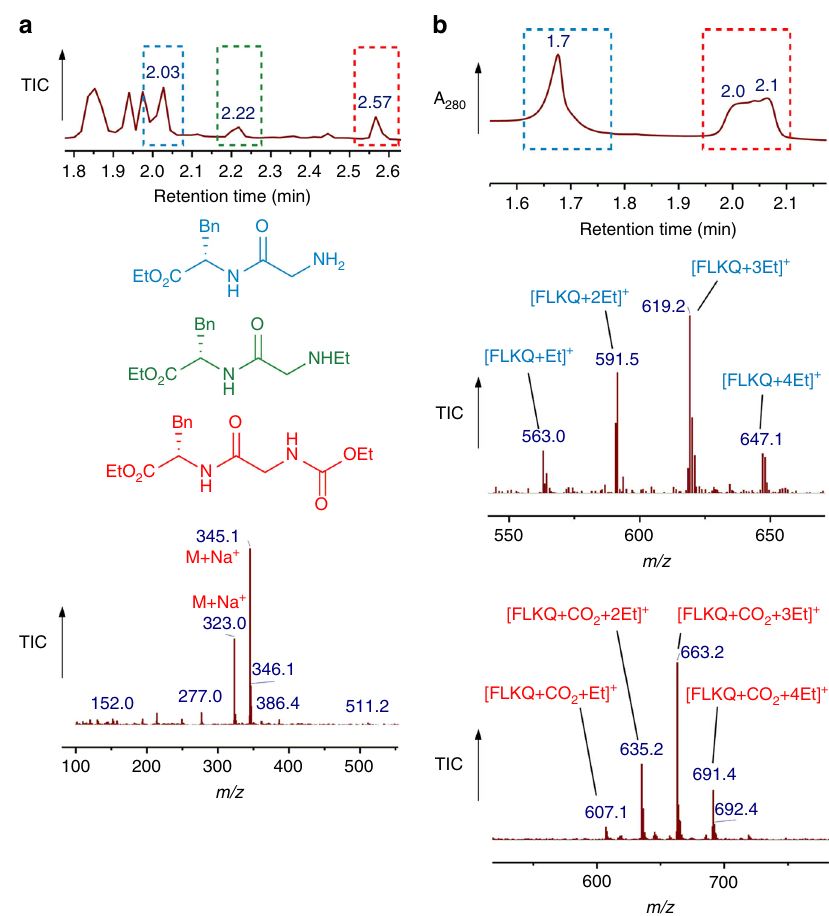
Fig. 4 Carbamate trapping on di- and tetrapeptides. a Total ion chromatogram of the carbamate-trapping reaction mixture of Gly-Phe with TEO, and m/z pro fi le for species at retention time 2.57 min. The major products of the trapping reaction are Gly-Phe ethylated on the Phe- α -carboxylate (retention time 2.03 min), Gly-Phe ethylated on the α -carboxylate of Phe and the α -NH 2 group of Gly (retention time 2.22 min) and Phe-Gly ethylated on the carbamate of the α -NH 2 -group of Gly and the α -carboxylate group of Phe (retention time 2.57 min). b Total ion chromatogram of the carbamate-trapping reaction mixture of FLKQ tetrapeptide with TEO and m/z pro fi les for species at retention time 1.7 and 2.0 – 2.1 min. The major products of the trapping reaction are shown as FLKQ with 1-4 ethylation groups (retention time 1.7 min) and FLKQ with 1 trapped carbamate and 1-4 ethylation groups (retention time 2.0 – 2.1